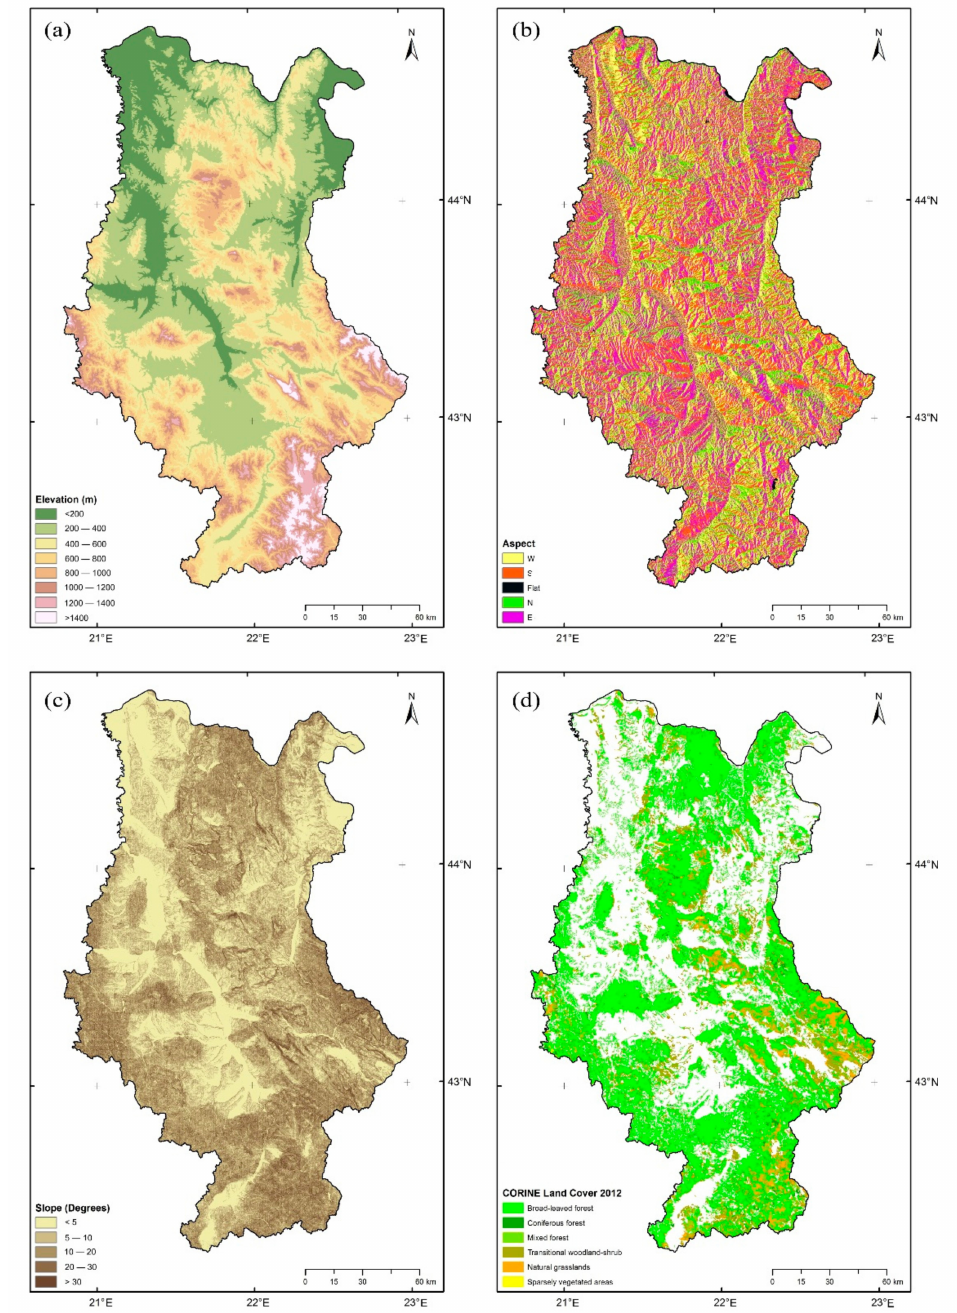
Figure 2. Categorical predictors related to forest fire in Eastern Serbia. ( a ) Classes of elevation; ( b ) aspect classes; ( c ) slope categories; ( d ) land cover categories obtained by CORINE 2012. Data on drought code (DC), as a component of the Canadian Forest Fire Weather In- dex [40], were obtained from the Republic Hydrometeorological Service of Serbia (http://www.meteoalarm.rs/eng/fwi_osm.php) as tables with coordinates of